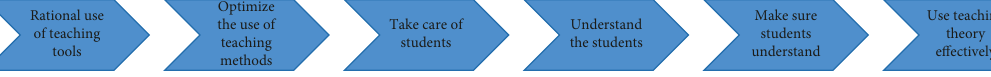
Figure 11: Matters needing attention.